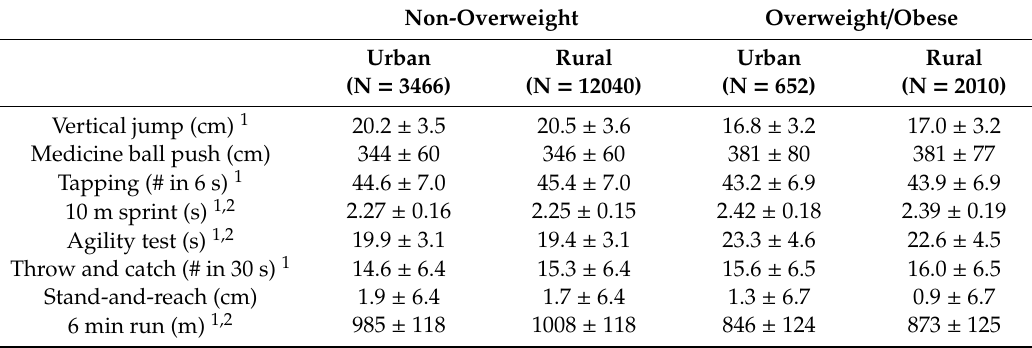
Table 3. Physical fitness by living area separately for non-overweight and overweight / obese. Values are mean ±